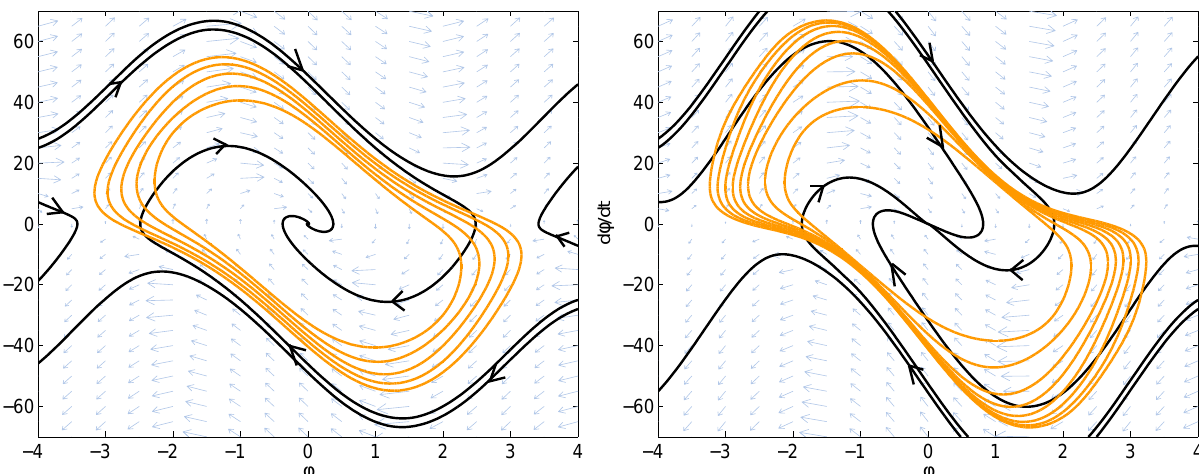
Figure 10. Comparison of the domain-of-attraction. Left : linear design. Right : nonlinear